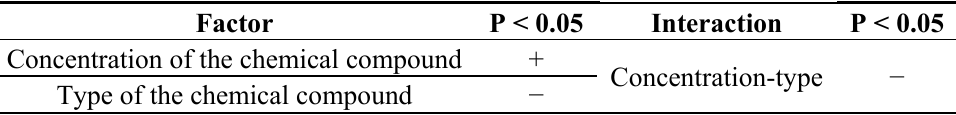
Table 3. Significance analysis of the main factors (chemical compound concentration and type), and their mutual interactions on the porosity of the formed sinters (MANOVA).